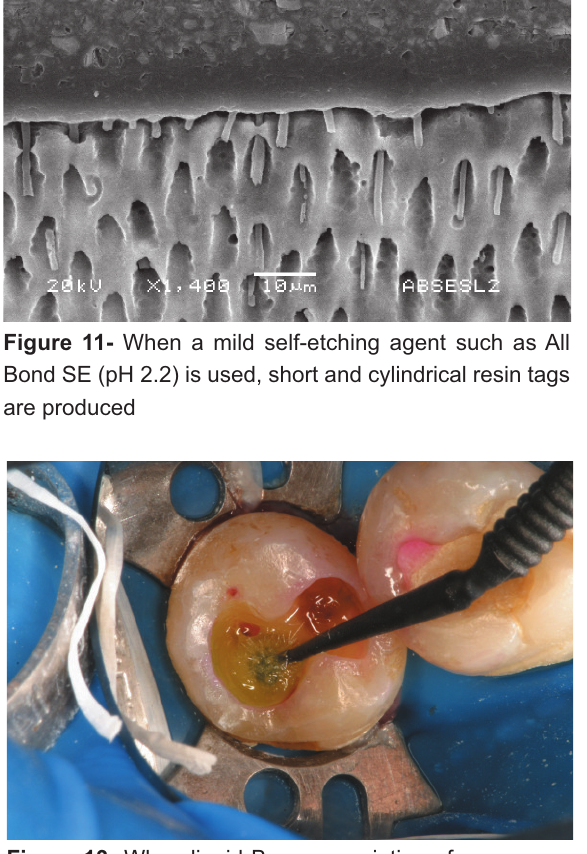
Figure 13- When liquid B, an association of monomers, 922,'"*.+"(.(-(*-%':"(&"-'*.&>,'',+"(."-%"-$,")*C(-!:"-$,"*)(+" reaction takes place. The operator needs to mix both liquids (A and B) inside the cavity. The pink appearance